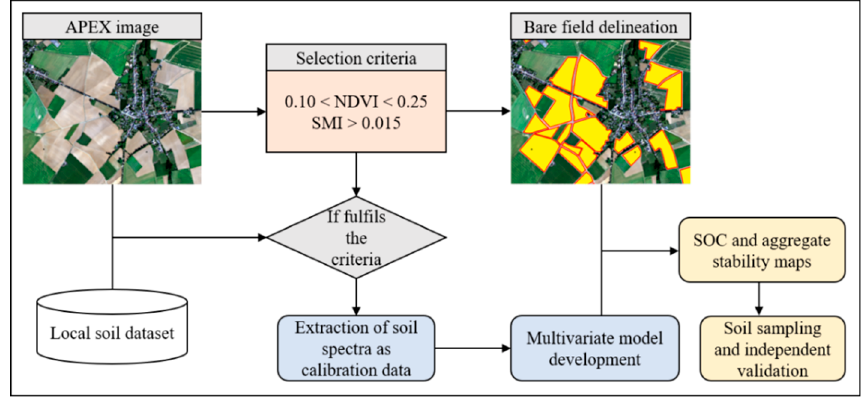
Figure 2. Flow chart of the APEX image processing, model development and evaluation procedure.